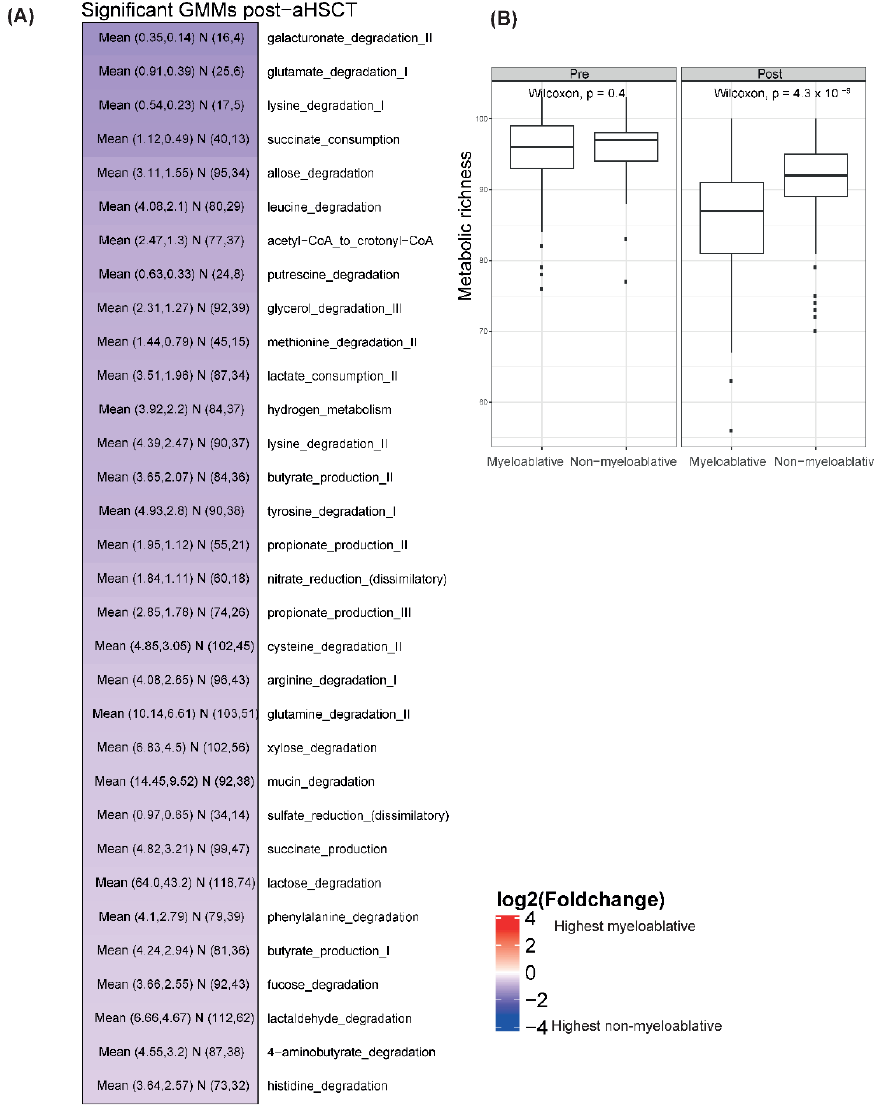
Figure 3. Associations between GMM profiles and conditioning regimens. ( A ) Heatmap on GMM level of the log2 fold changes between the non-myeloablative and myeloablative groups in the post- aHSCT sampling period, no comparisons were significant for the pre-aHSCT period. The plot shows all GMMs that are significantly different using a Wilcoxon test and have an absolute log2 fold change of above 0.5. Blue colors show that the mean abundance of a GMM is higher in the non-myeloablative group than in the myeloablative one and red shows the opposite direction. The text in the cells shows “Mean (mean (non-myeloablative), mean (myeloablative)) N (number of non- myeloablative samples with the GMM present, number of myeloablative samples with the GMM present)”. The total numbers of samples are pre-aHSCT myeloablative = 67, pre-aHSCT non-mye- loablative = 104, post-aHSCT myeloablative = 76, post-aHSCT non-myeloablative = 116. ( B ) Boxplots of metabolic richness in patients undergoing myeloablative conditioning vs. non-myeloablative in pre-aHSCT and post-aHSCT samples. Wilcoxon tests were performed per time period.